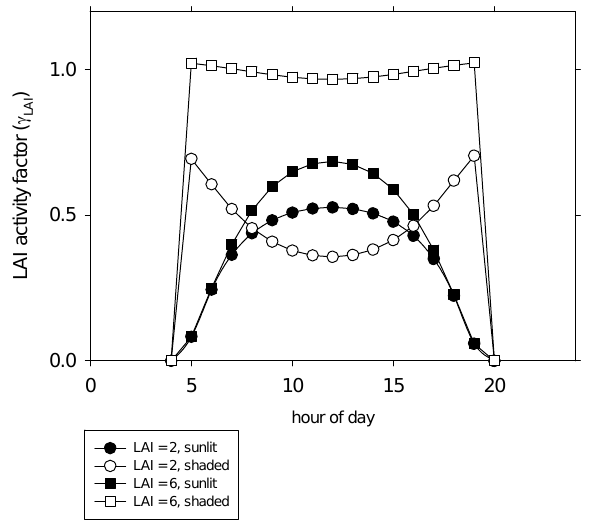
Fig. 3. Variation of γ LAI with respect to hour of the day for sunlit and shaded fraction and for LAI of 2 and